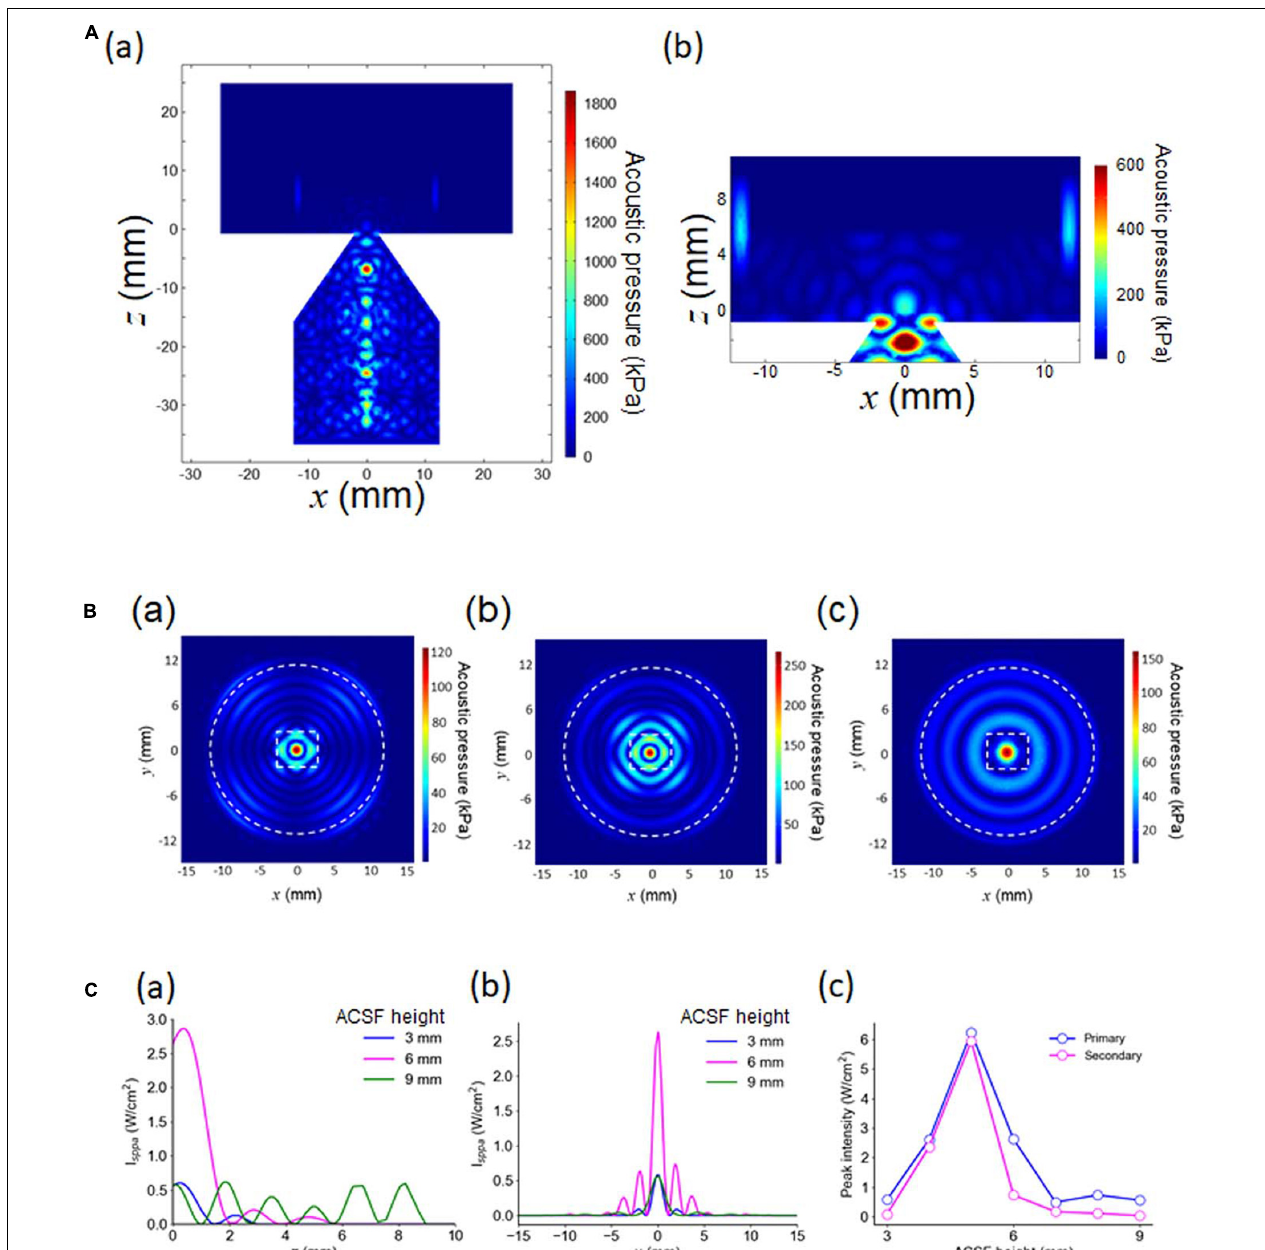
FIGURE 4 | Numerical results of 3D modeling. (A) In (a), the acoustic pressure distribution in the vertical cross section passing through the central axis. The size parameters are d = 4.0 mm and l = 20 mm. In (b), an expanded view of (a), including a cross-section of the MEA chamber, for the same size parameters. (B) The acoustic pressure distribution in the horizontal cross section located at z = 0 mm in (a) (height = 35.7 mm in Figure 2A ). The height of the ACSF solution in the chamber was the only difference among the three plots; the other parameters were exactly the same. The three plots in (a–c) illustrate the pressure distribution patterns for a fluid height of 3, 6, and 9 mm, respectively. (C) Intensity ( I sppa ) distributions for vertical and horizontal cross sections. In (a), the intensity distribution passing through the central axis ( z ≥ 0; x = 0 and y = 0 in mm) is shown for a fluid height of 3, 6, and 9 mm. In (b), the intensity distribution on the horizontal plane at z = 0 with y = 0 in mm. In (c), a summary of the peak intensity, numerically obtained as a function of the height of the ACSF solution in the MEA